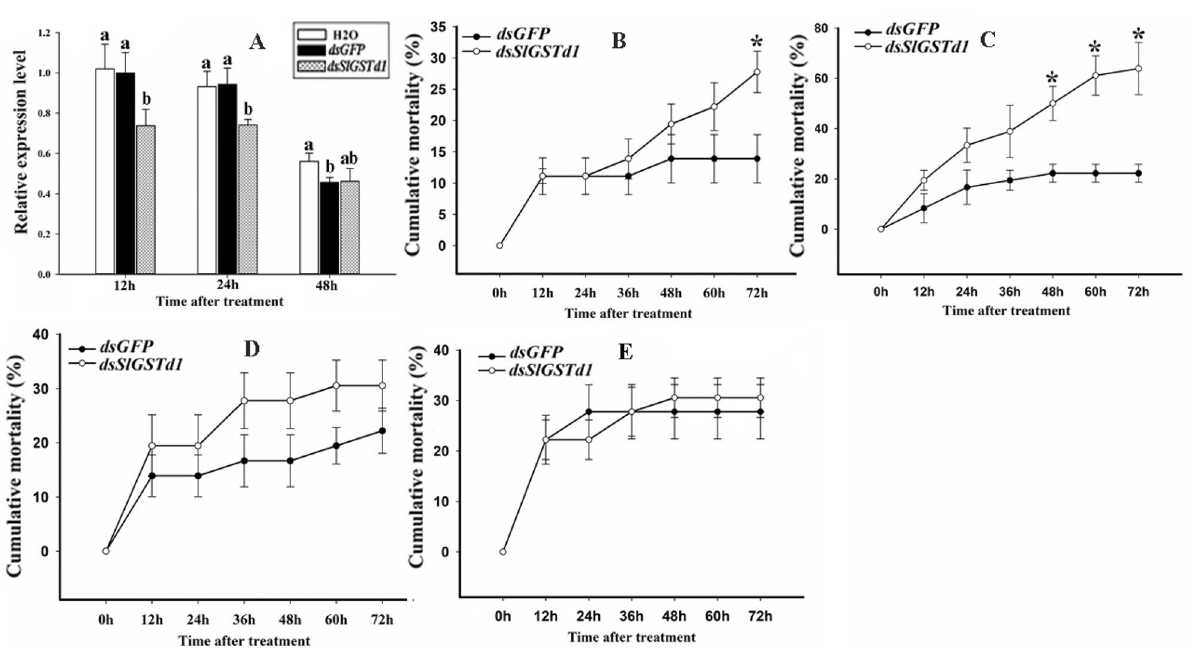
Figure 4. The relative expression of SlGSTd1 and bioassay results of larvae in S. litura after RNAi treatment. ( A ) The relative expression of SlGSTd1 in S. litura after larvae feeding on dsRNA or H 2 O. Different lowercase letters indicated significant differences analyzed by ANOVA followed by Tukey’s HSD test ( P < 0.05). ( B – E ) Mortality of larvae treated by fenvalerate ( B ), cyhalothrin ( C ), beta-cypermethrin ( D ), chlorpyrifos ( E ) after feeding on dsRNA. * Indicated significant differences in larvae mortality between feeding on dsSlGSTd1 and dsGFP (student’s t-test, P <